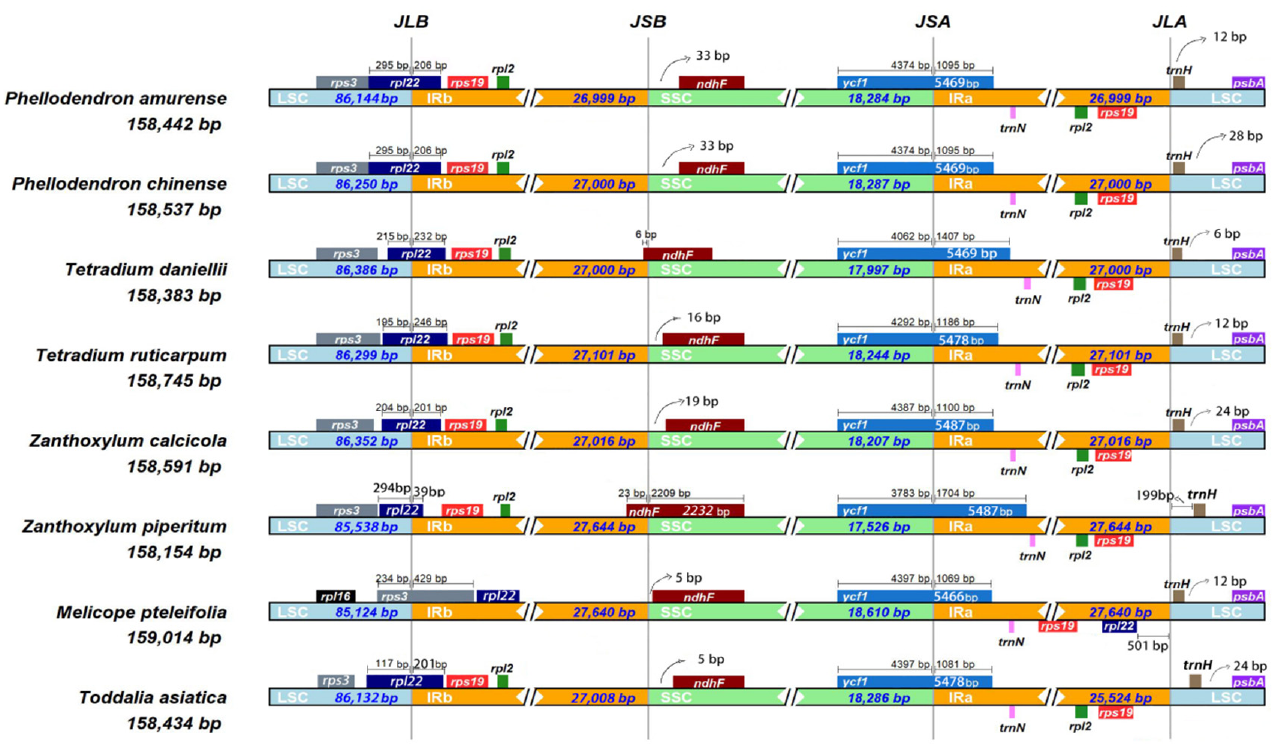
Figure 2. Comparison of the borders of LSC, SSC, and IR regions among eight plastomes of five genera in Amyridoideae. Different colour boxes indicate specific genes.